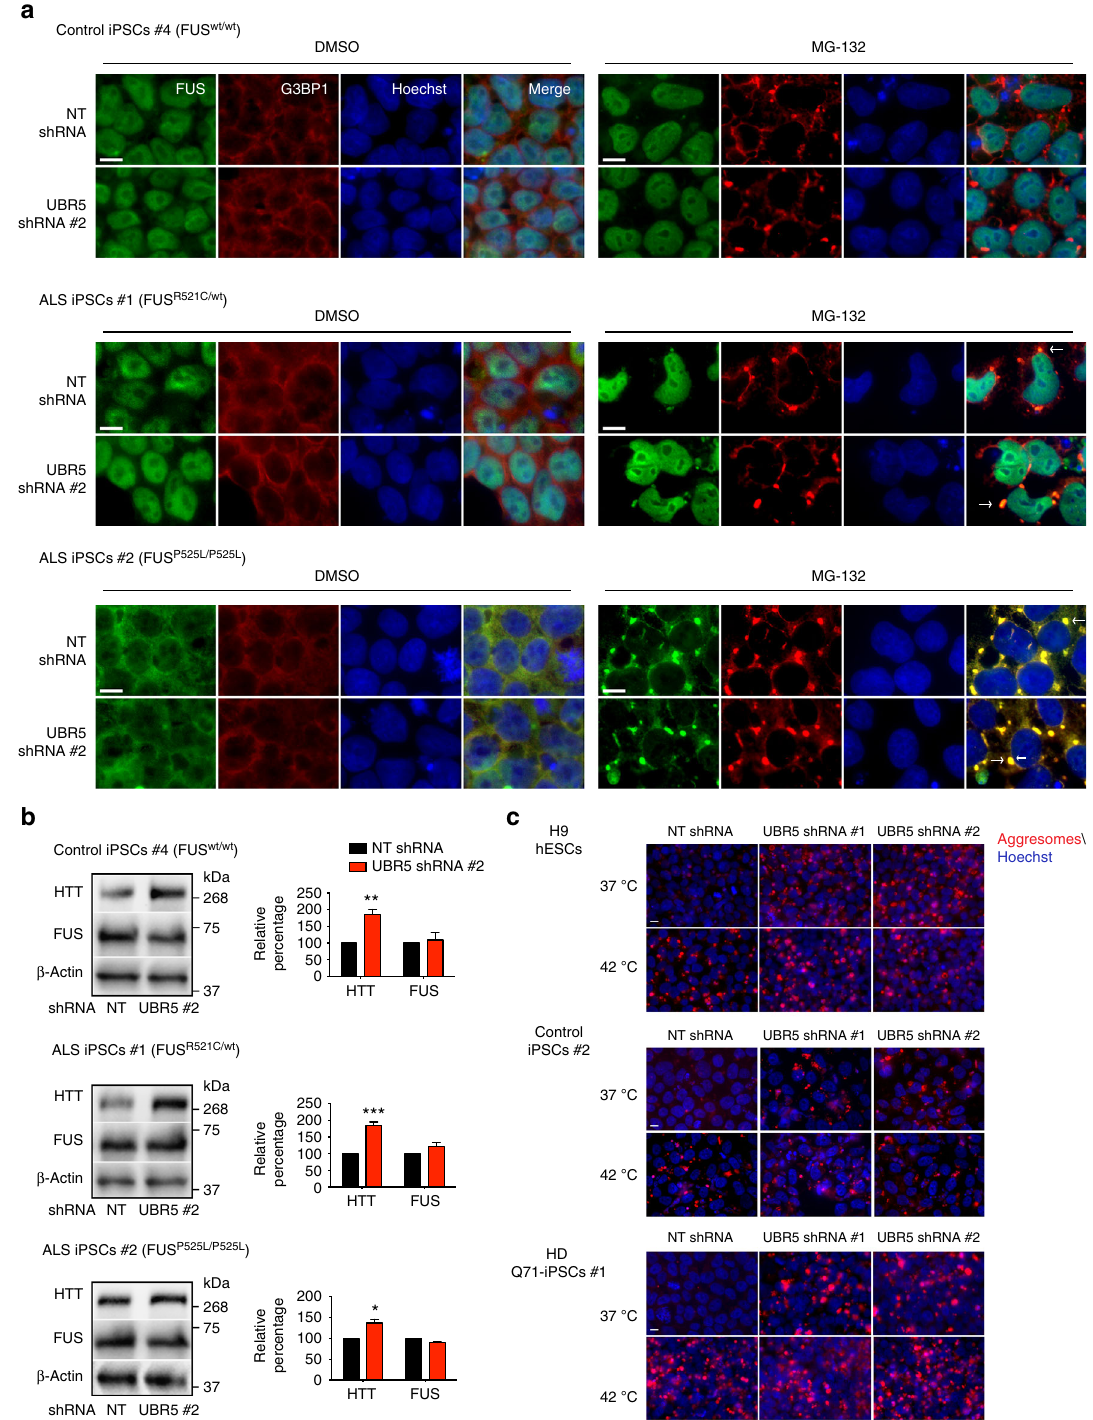
Fig. 7 Loss of UBR5 triggers aggresome formation in pluripotent stem cells. a Immunocytochemistry of control iPSCs #4 (FUS wt/wt ), ALS-iPSCs #1 (FUS R521C/wt ) and ALS-iPSCs #2 (FUS P525L/P525L ) with anti-FUS antibody. G3BP1 and Hoechst 33342 staining were used as markers of stress granules (SGs) and nuclei, respectively. Proteasome inhibition: 5 µ M MG-132 for 6 h. Scale bar represents 10 μ m. Arrows indicate examples of co-localization of FUS with SGs. The images are representative of three independent experiments. b Western blot analysis with antibodies to HTT and FUS of ALS-iPSC lines upon UBR5 knockdown. The graphs represent the relative percentage values of HTT and FUS to the respective NT shRNA iPSCs corrected for β -actin loading control (mean ± s.e.m. of three independent experiments for each line). All the statistical comparisons were made by Student ’ s t -test for unpaired samples. * P < 0.05, ** P < 0.01, *** P < 0.001. c Staining of aggresomes in H9 hESCs, control iPSCs #2 and HD Q71-iPSCs #1. Hoechst 33342 staining was used as a marker of nuclei. Heat stress: 42 °C for 4 h. Scale bar represents 10 μ m. The images are representative of two independent experiments for